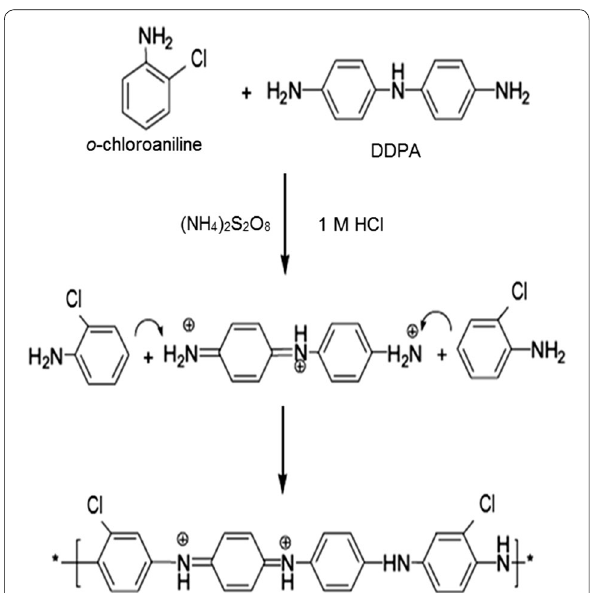
Fig. 1 Schematic illustration of polymerization of o